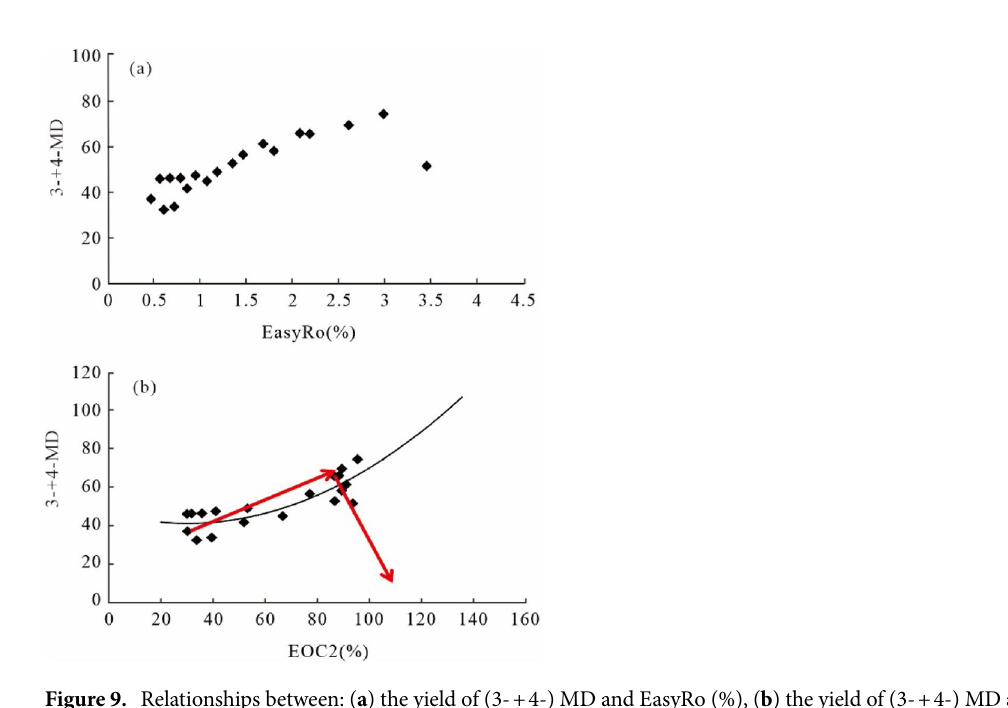
Figure 9. Relationships between: ( a ) the yield of (3- + 4-) MD and EasyRo (%), ( b ) the yield of (3- + 4-) MD and EOC